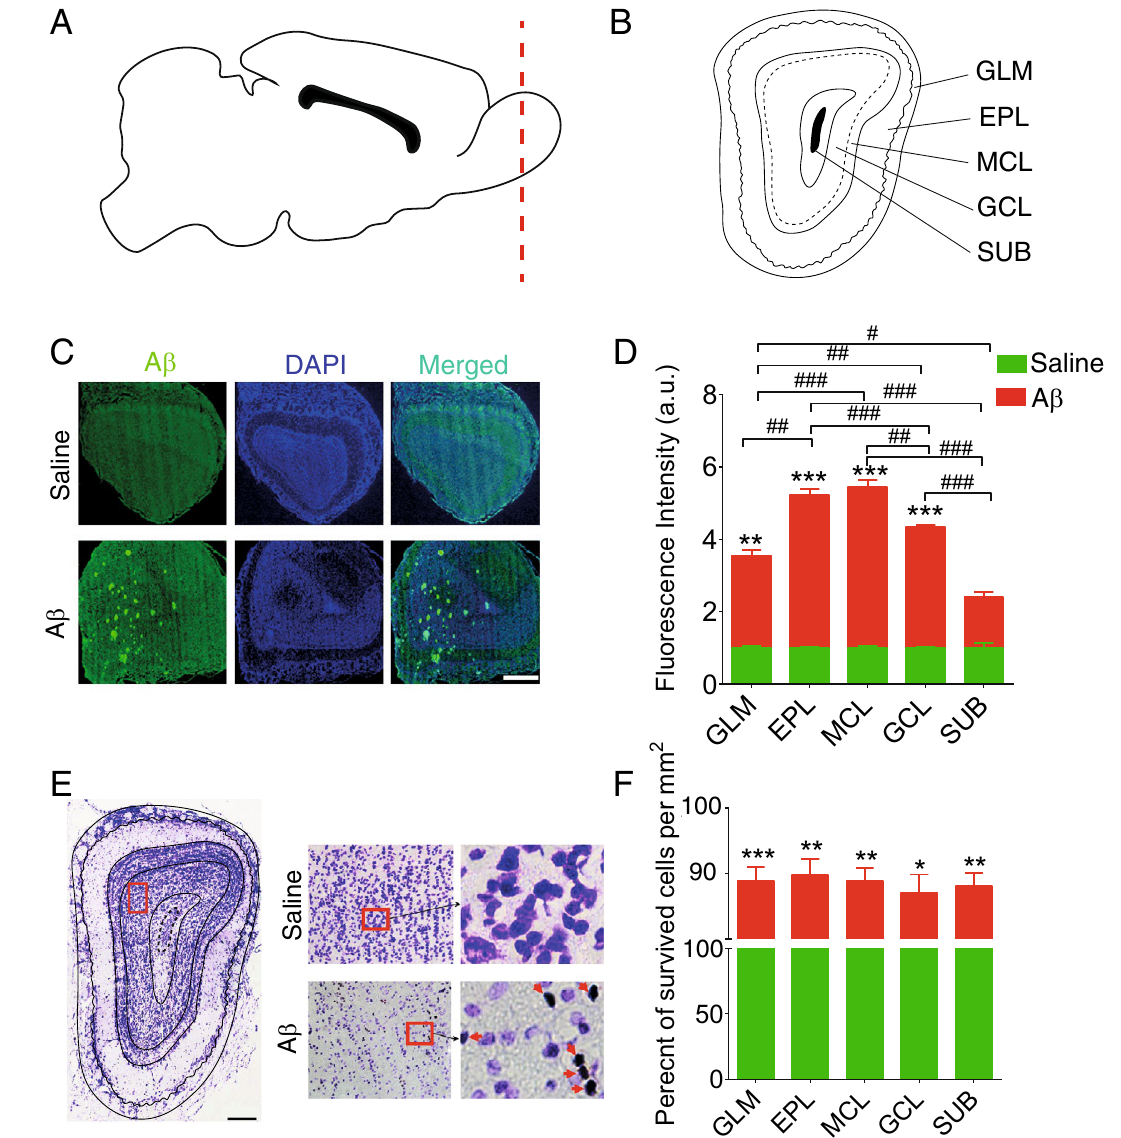
Figure 3. Survived cells in the OB. ( A and B ) Schematic representation of OB subregions. ( C ) a sample of immunostaining sections from OB of animals that received i.c.v. saline and Aβ. ( D ) Immunostaining of anti-Aβ 1-42 indicated a high level of plaque accumulation in Aβ animals compared to the saline group. ( E ) Representative of OB section stained by Nissl method to evaluate the survived cells in OB subregions. ( F ) Aβ animals demonstrate significantly lower survival cells in this region compared to the saline group. Red arrows show dense bodies of dead cells. Aβ amyloid-beta, OB olfactory bulb, GCL granule cell layer, GLM glomerular layer, EPL external plexiform layer, MCL mitral cell layer, SUB subependymal layer, * p < 0.05, ** p < 0.01, *** p < 0.001 compared to saline. # p < 0.05, ## p < 0.01, ### p < 0.001 comparision among OB subregions in Aβ